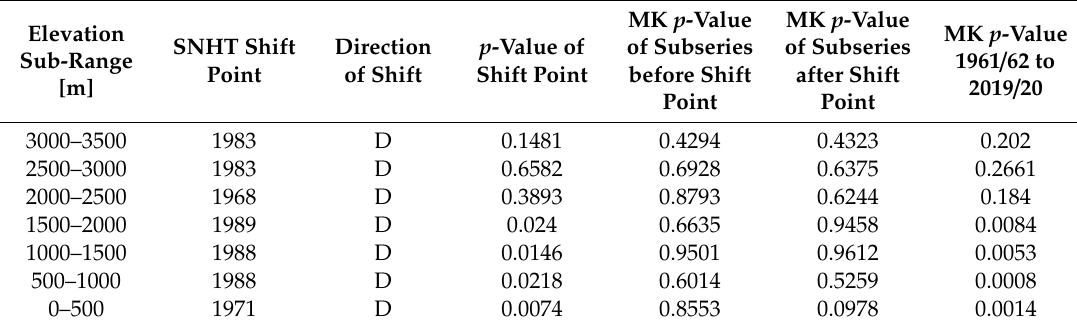
The period investigated covers the seasons of 1961 / 62 to 2019 / 20. D =